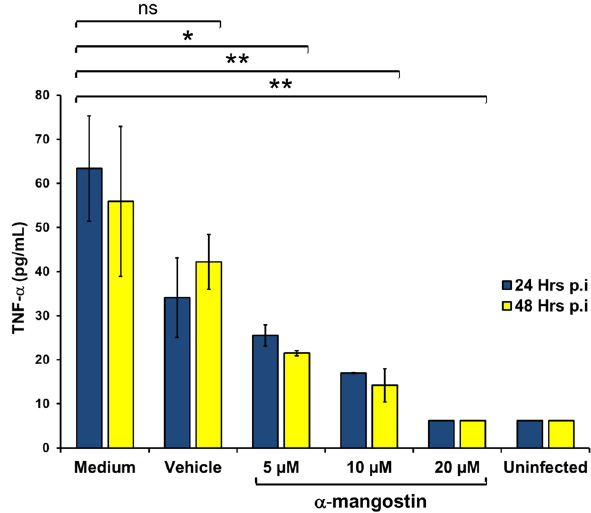
Fig. 2 The effect of α-mangostin treatment to TNF-α expression in DENV-infected PBMC at 24- and 48-h post infection. Statistical sig- nificance: ns = not significant; *p < 0.05; **p < 0.01